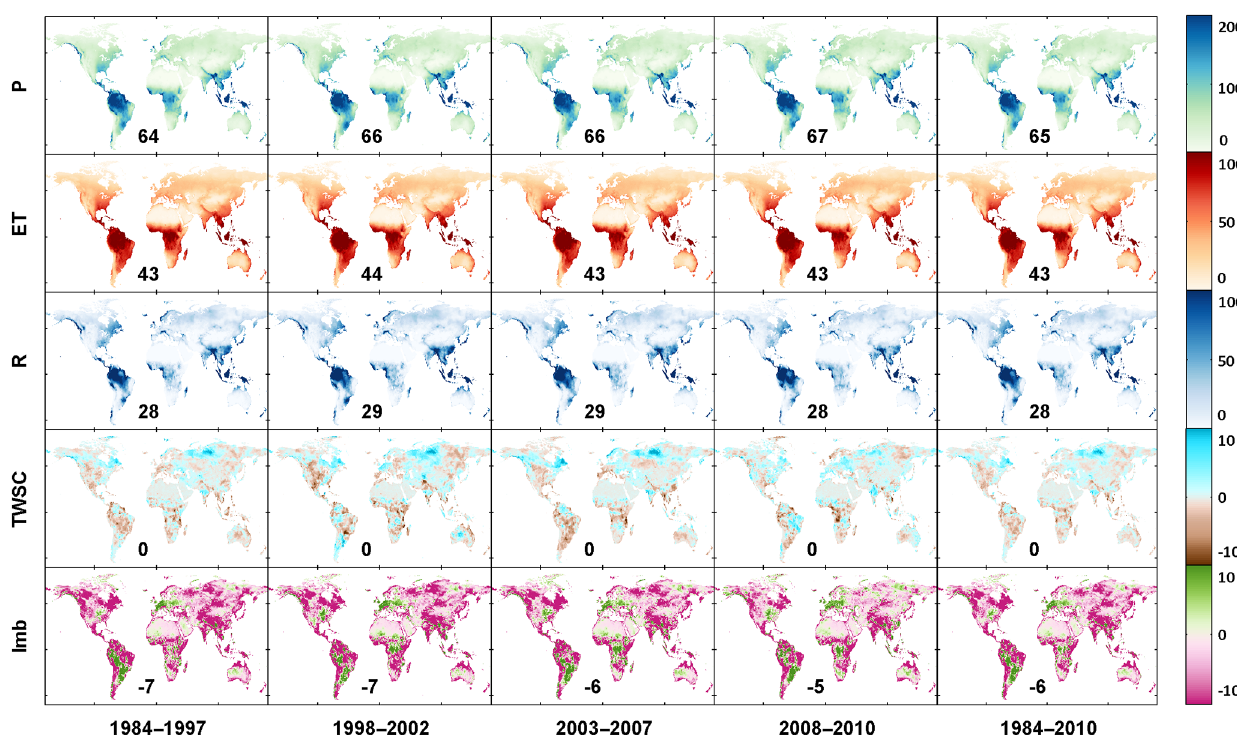
Figure 12. Monthly mean (mmmonth − 1 ) of different water budget terms (from the first row to the bottom: precipitation, evapotranspiration, runoff, total water storage change, imbalance) before water balance constraint throughout different periods (from the left to the right: 1984– 1997, 1998–2002, 2003–2007, 2008–2010, and 1984–2010; the numbers listed on each subpanel are the monthly mean value for each merged water budget variable before water balance constraint (mmmonth − 1 ) during different subperiods (Greenland and Antarctica excluded). This is the same as in Figs. S4 and S5 in Supplement II but for the merged water budget variable after water balance constraint (mmmonth − 1 ) and the non-closure error attributions to each water budget variable (%) ).